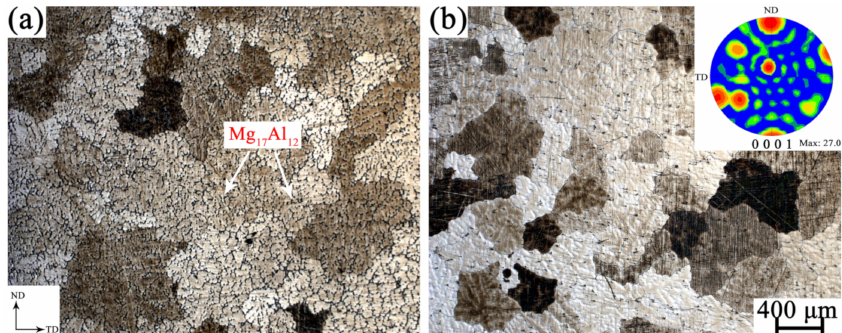
Figure 1. Microstructures of ( a ) as-cast and ( b ) as-homogenized AZ31B alloys. (Two figures have the same scale bars).